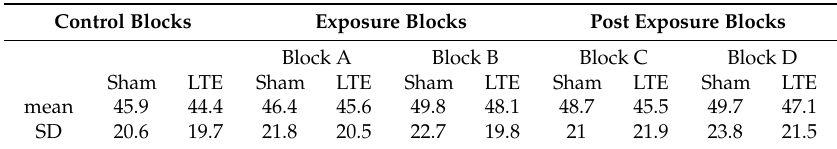
Table 1. Means and standard deviations of subjective pain ratings assessed using the Visual Analogue Scale for each experimental block.